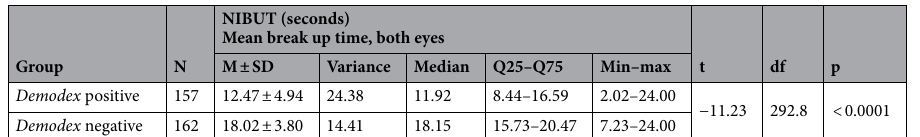
Group N Demodex positive 157 12.47 ± 4.94 24.38